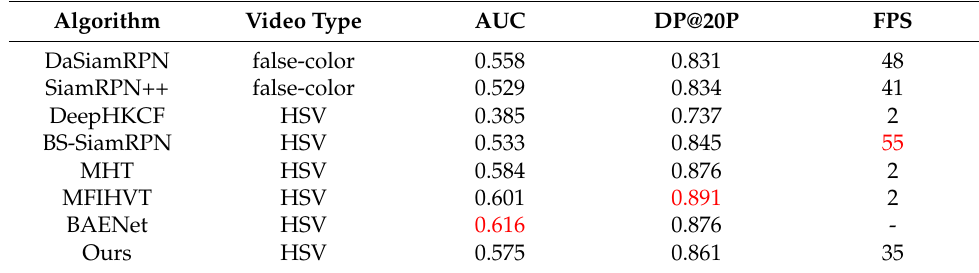
Table 4. Performance comparison with other